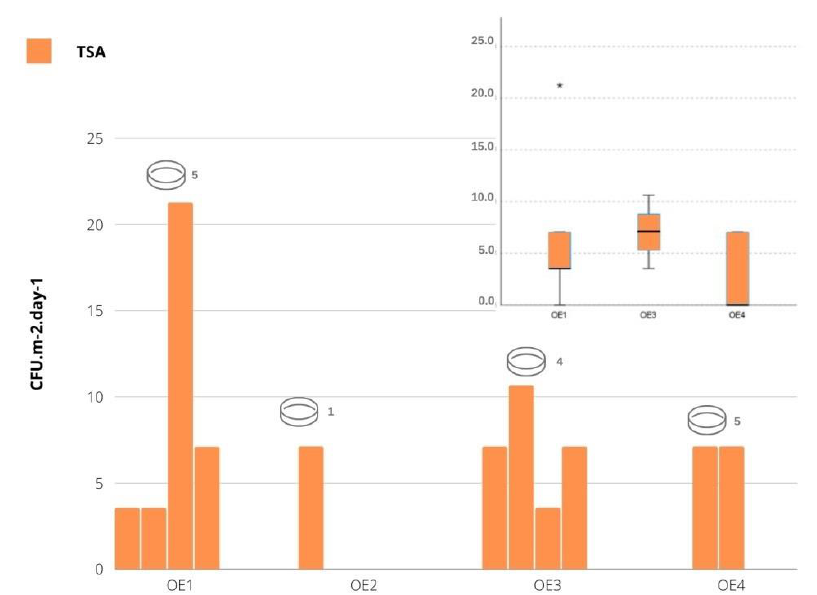
Figure 3. Bacterial contamination in the four sampled locations observed in TSA. On the top right is the boxplot for comparison of bacterial contamination in TSA medium between sampled areas (excluding OE2, since it has a single record). * severe outlier